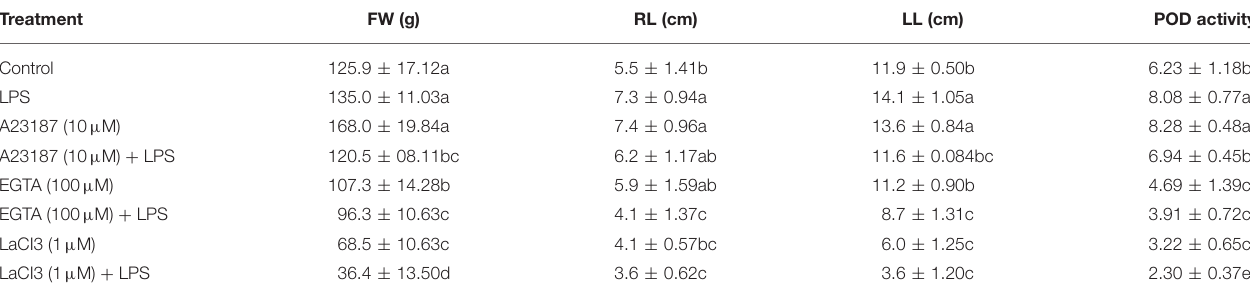
TABLE 2 | Effect of A23187, EGTA and LaCI 3 on wheat seedling growth and POD activity.